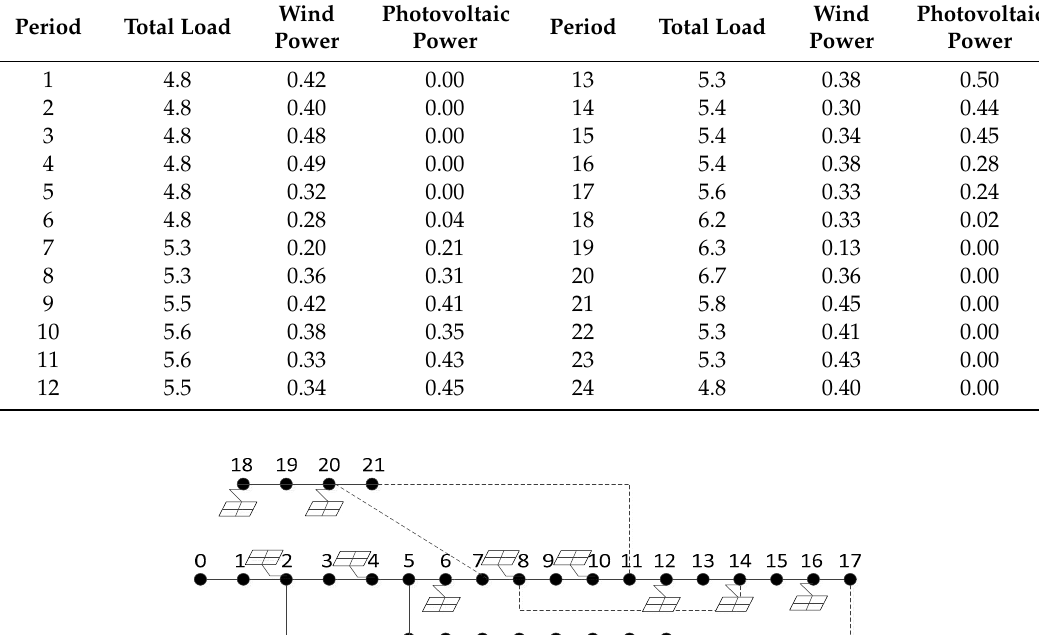
Table 3. Load, wind power and photovoltaic power of a typical day (MW).